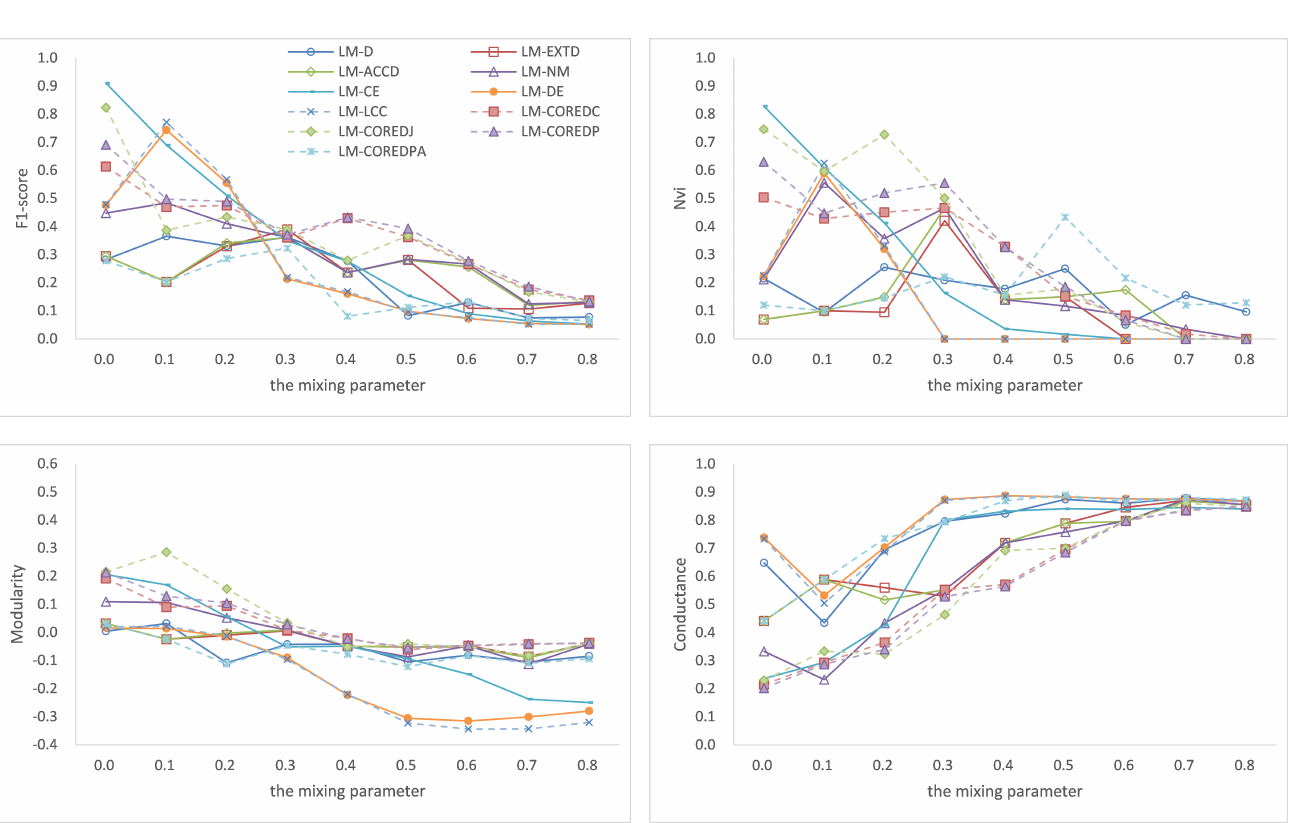
Figure 7. The F1-score, Nvi, modularity and conductance of the communities detected by different local seeding